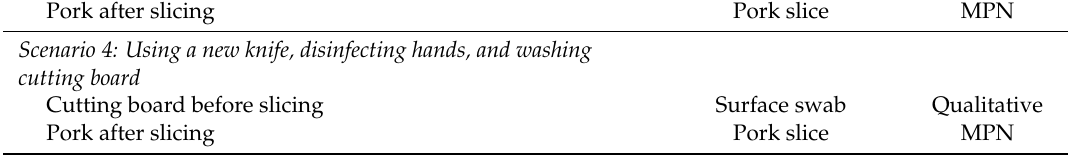
Surface swab Qualitative